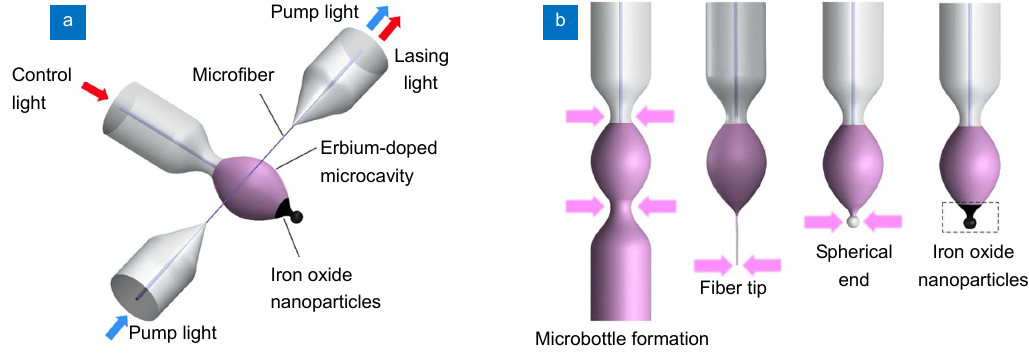
Fig. 6 | ( a ) Schematic of an all-optical tunable microlaser. ( b ) Fabrication process of the erbium-doped hybrid microbottle cavity coated with iron oxide nanoparticles. Figure reproduced from ref. 68 , American Chemical Society.